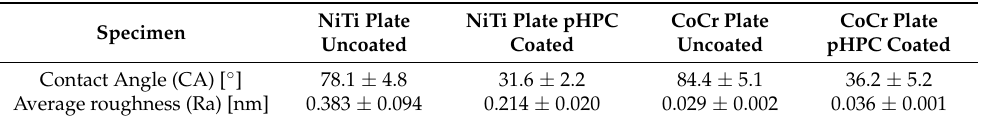
Table 1. Contact angle (CA) and arithmetic roughness of coated and uncoated NiTi and CoCr specimens.